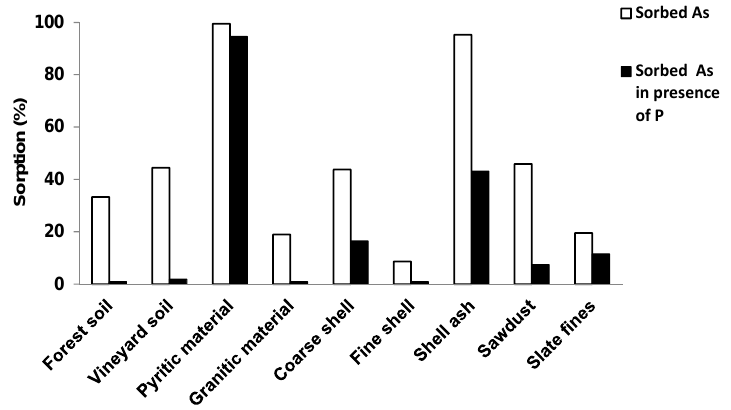
Figure 2. Sorbed As (%) when a concentration of 3 mmol As(V) L − 1 is added, showing results in absence of P and in presence of 6 mmol P L − 1 .